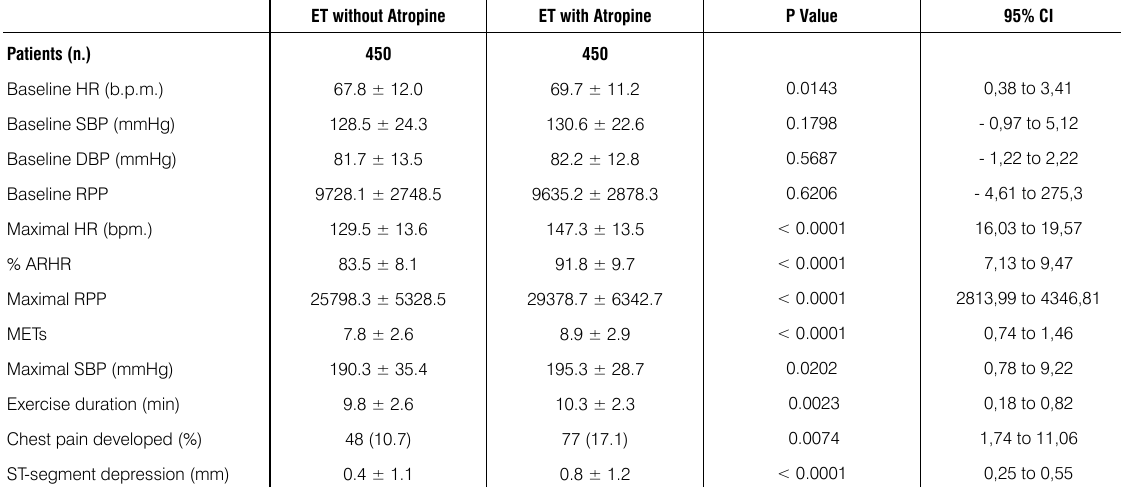
Table 2. Baseline and Maximal Clinical, Electrocardiographic, and Hemodynamic Parameters. ET without Atropine ET with Atropine P Value 95% CI Patients